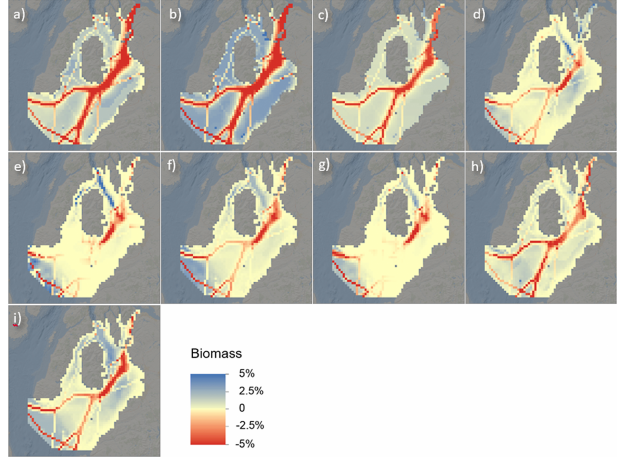
Fig. 8. Firth of Clyde biomass distribution and intensity changes up to 5% in response to the introduction of marine spatial planning start-up pressures after a 40-yr simulation period for various compartments. (A) Seals. (B) Cetaceans. (C) Birds. (D) Sharks. (E) Rays and skates. (F) Cod. (G) Saithe. (H) Whiting. (I)